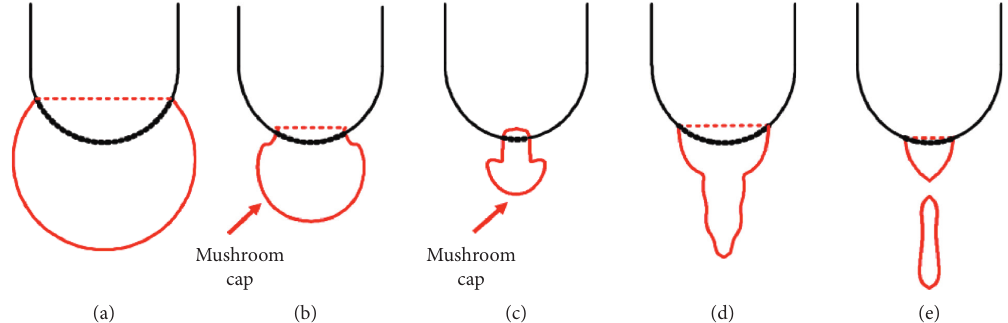
Figure 15: Description of morphological characteristics of inverted mushroom-like bubble. (a) First maximum volume. (b) Inverted mushroom. (c) Mushroom-like. (d) Second maximum volume. (e) Second minimum